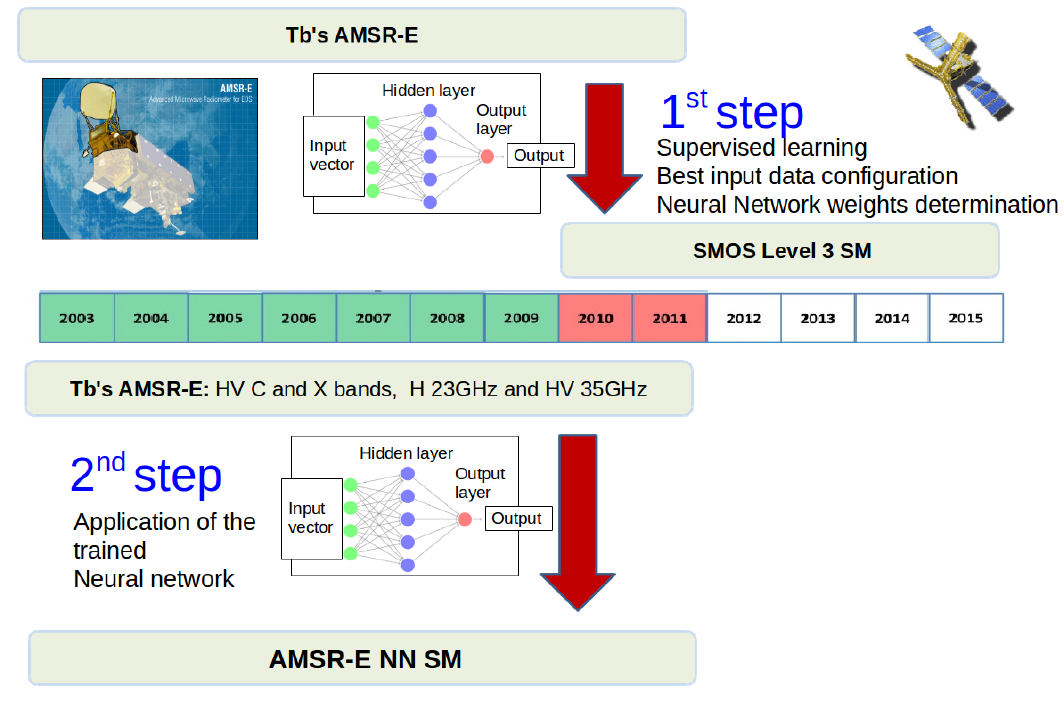
Figure 2. Schema of the methodology used in this